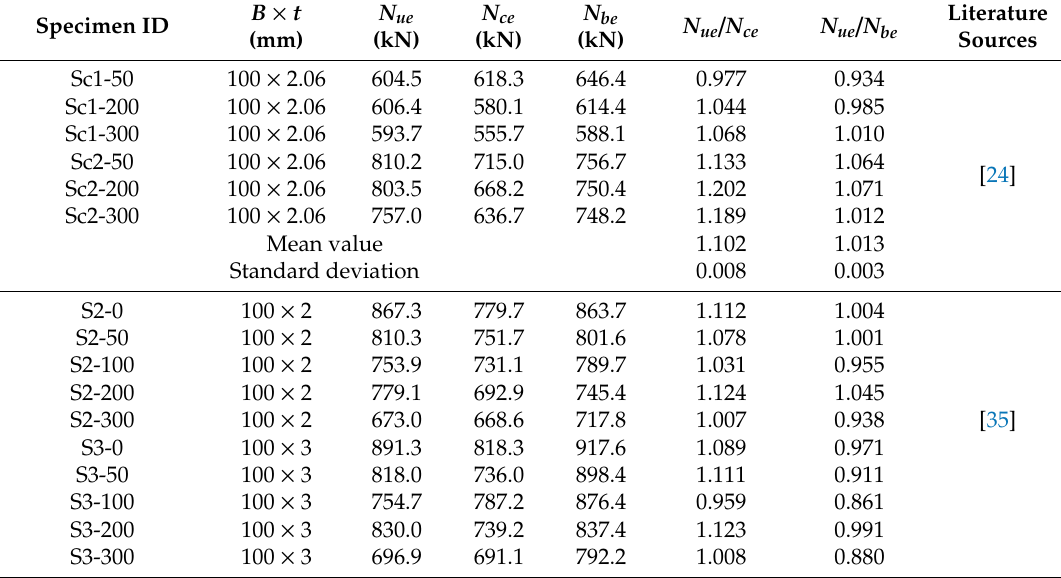
Table 1. Bearing capacity comparisons between the numerical results and experimental results of specimens exposed to freeze–thaw